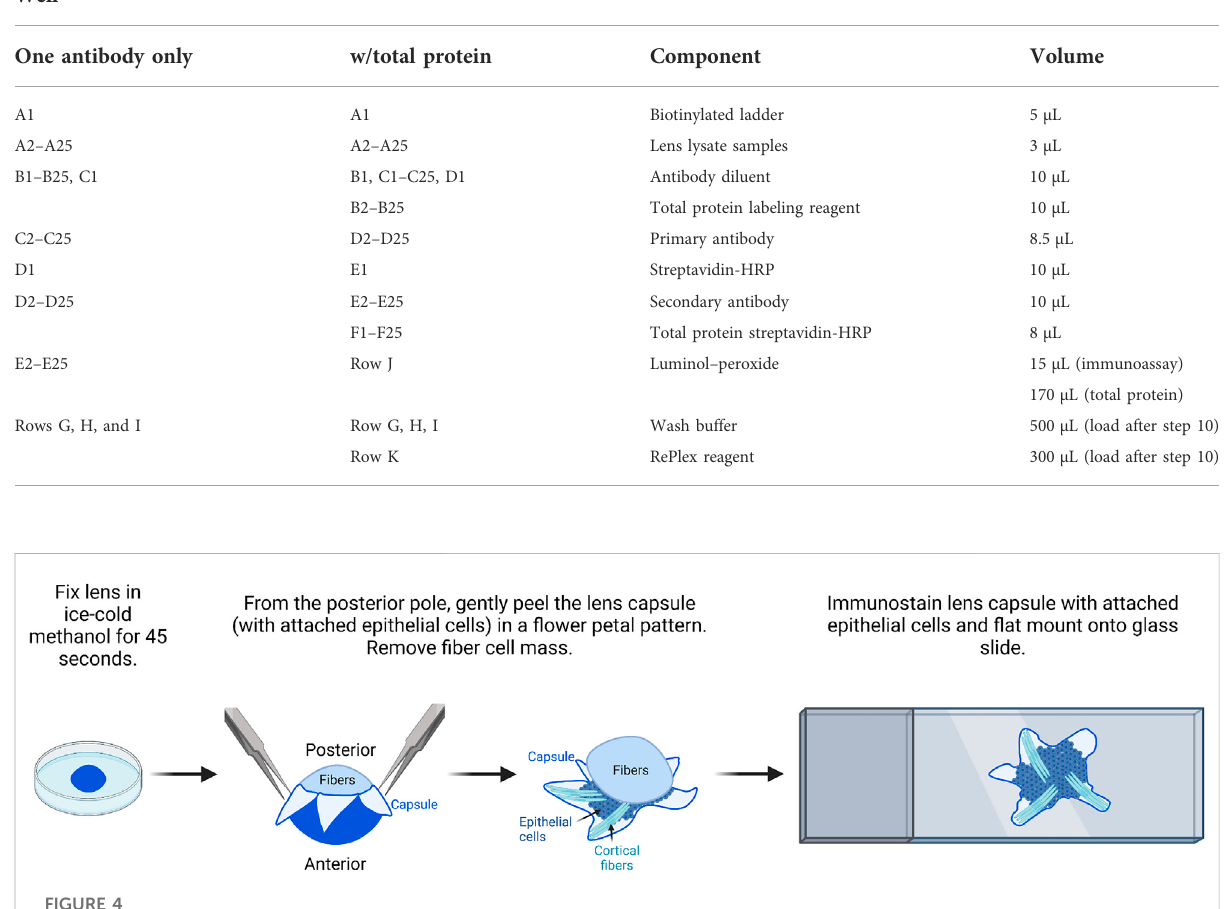
FIGURE 4 Flat mount imaging of lens epithelial cell monolayer. After methanol fi xation of the lens, gently peel the lens capsule with attached epithelial cells fromtheposteriorand remove the fi ber cell mass. Therewill beasmall amount of peripheral fi ber cells attached to the fl atmountsample. After immunostaining, fl at mount the lens capsule onto a glass slide in mounting media and then cover and seal with a coverslip for imaging. The image was drawn using Biorender and not drawn to